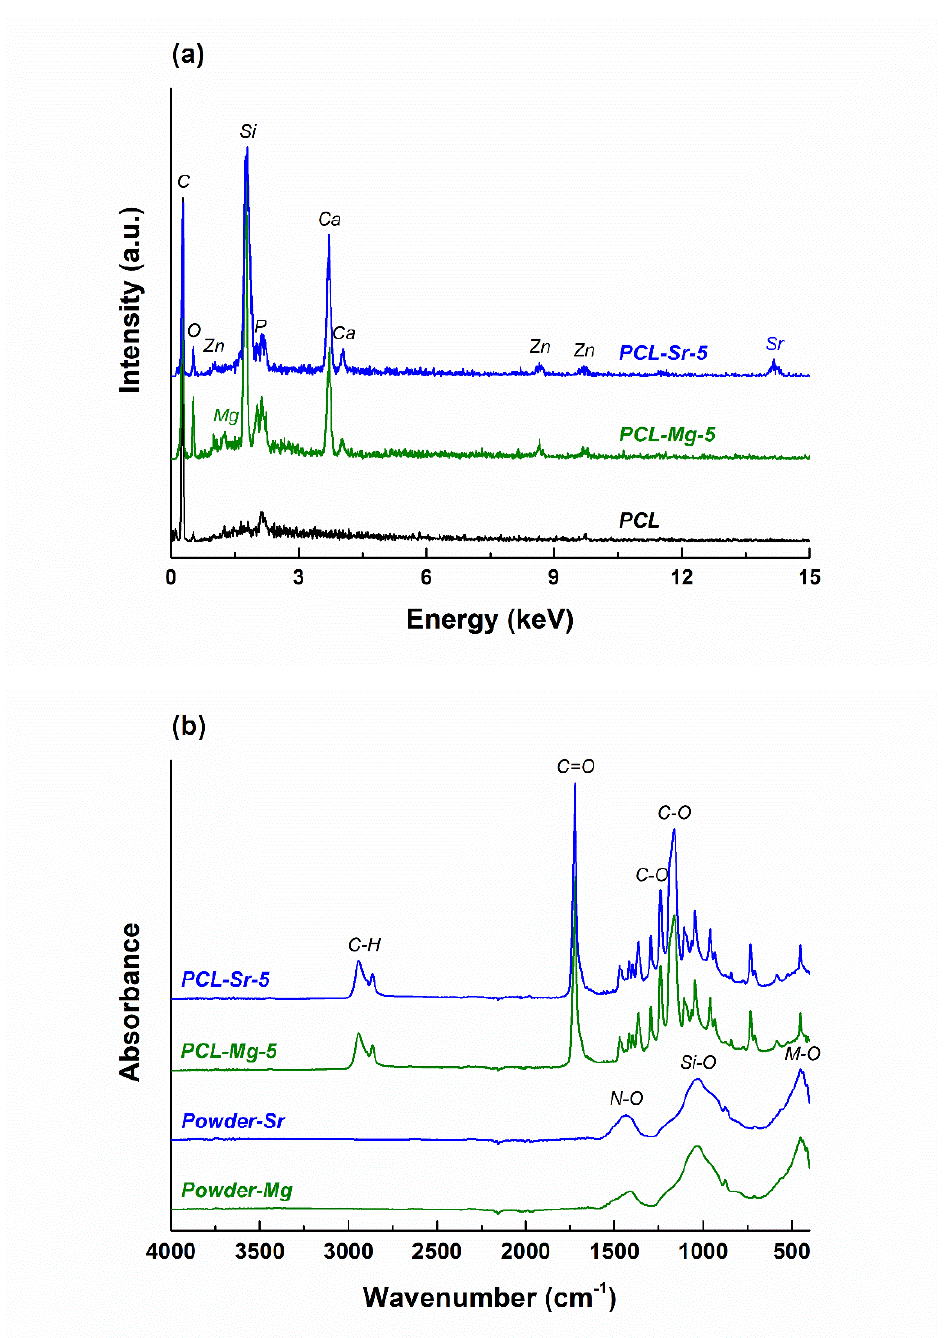
Figure 4. ( a ) EDX of PCL, PCL-Mg-5 and PCL-Sr-5 scaffolds and ( b ) FTIR spectra of Powder-Mg, Powder-Sr, PCL-Mg-5 and PCL-Sr-5 scaffolds.